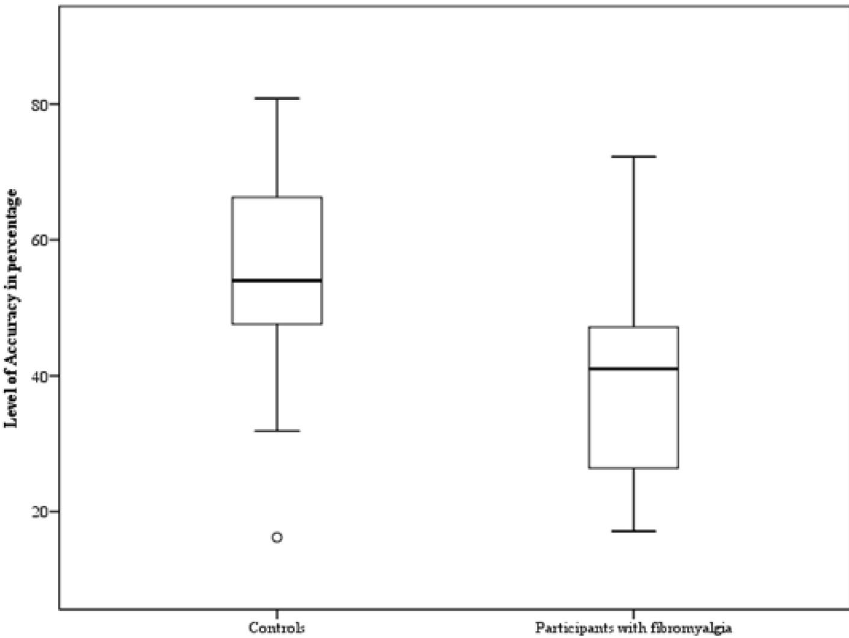
Figure 3. The mean relative to the level of accuracy expressed in percentage in the case of fearful expressions on the y-axis is shown for the two groups (controls vs participants with fibromyalgia). The minimum, the lower quartile, the median, the upper quartile, the maximum, and the outliers are